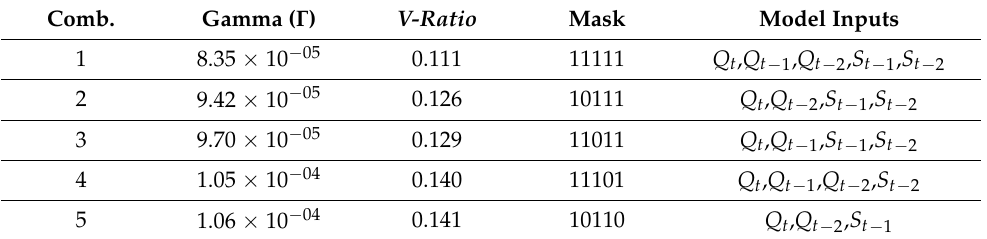
Table 3. Best input and output combinations based on GT for the Pirna gauging Station. Comb.